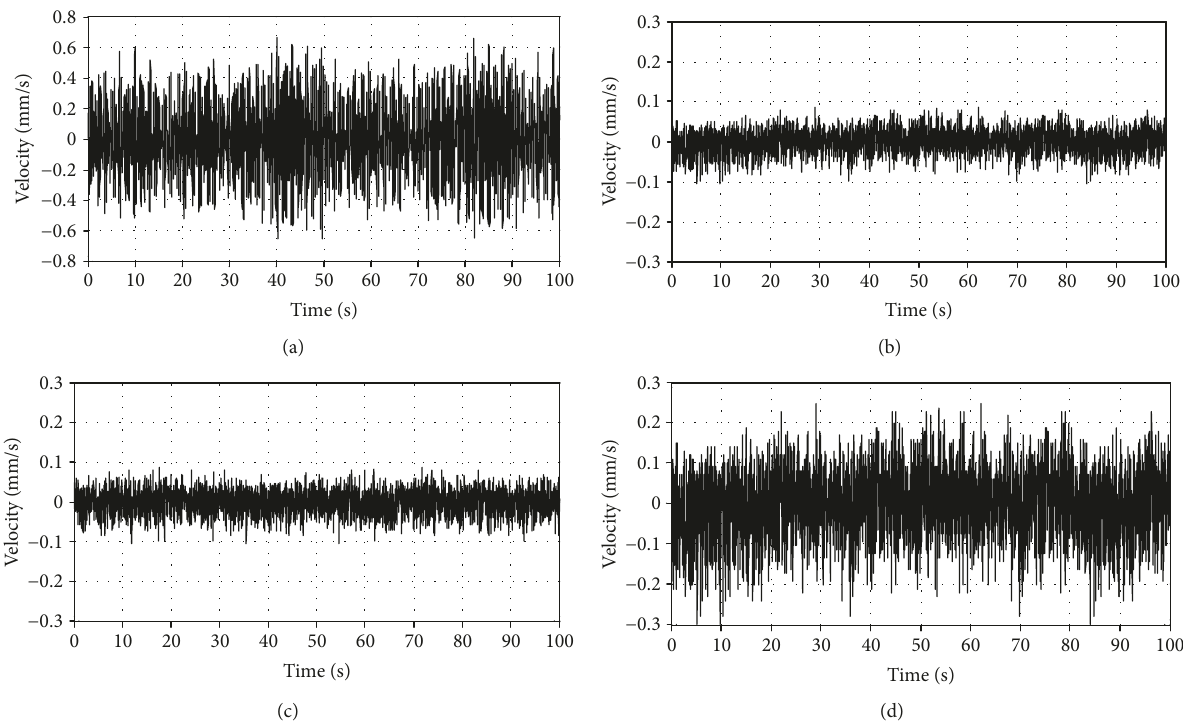
Figure 11: Velocity response to external disturbing force: (a) passive vibration isolation system, (b) AVIS with DCARC controller, (c) AVIS with DRC controller, and (d) AVIS with AC